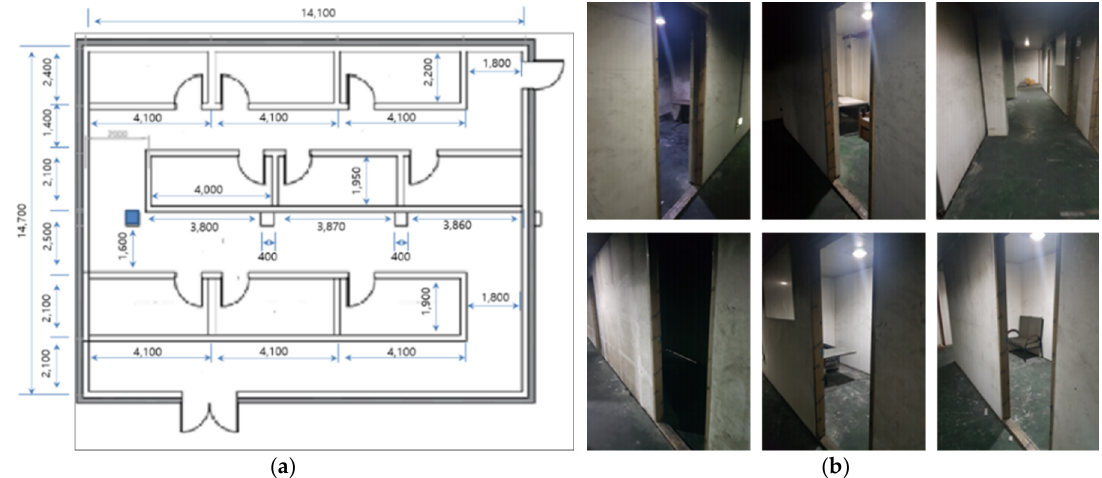
Figure 7. Test indoor environment: ( a ) top view of the environment; ( b ) all the rooms and corridors were basic in design).